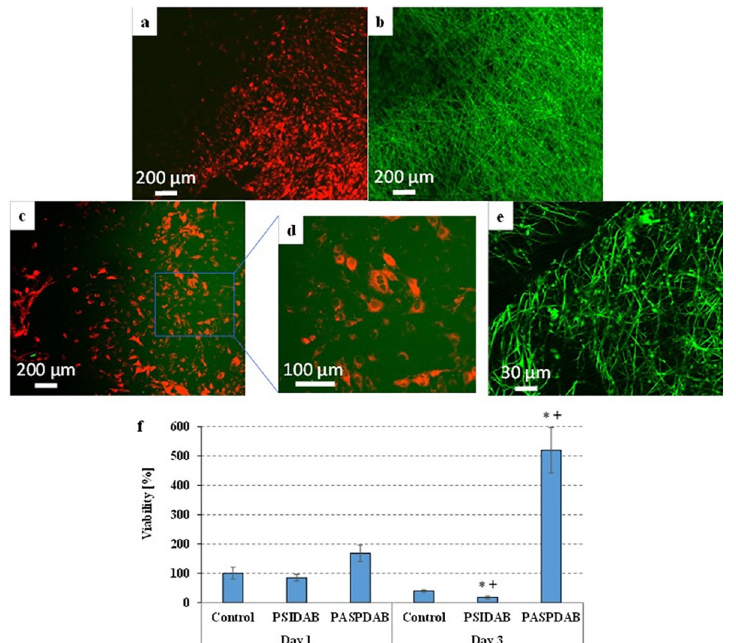
Fig 5. Multiphoton microscopic images of the Vybrant DiD-labelled MG-63 cells after 24-hour-long cultivation on the surfaces of "tissue culture" plastic plates (a) or PSIDAB (b) or PASPDAB based (c and d) fibrous membranes and PASPDAB membrane without cells as a control (e). The cells show red fluorescence due to the Vybrant DiD staining while the green color indicates the autofluorescence of the PSI or PASP membranes. Red and green channels are both shown on all pictures except the (e) where only the green was active. Viability of MG-63 cells after 1- or 3-day-long cultivation on the surfaces of "low cell binding" plastic plates (control) and PSIDAB or PASPDAB membranes (f). � p < 0.05 compared to the control. + p < 0.05 compared to day